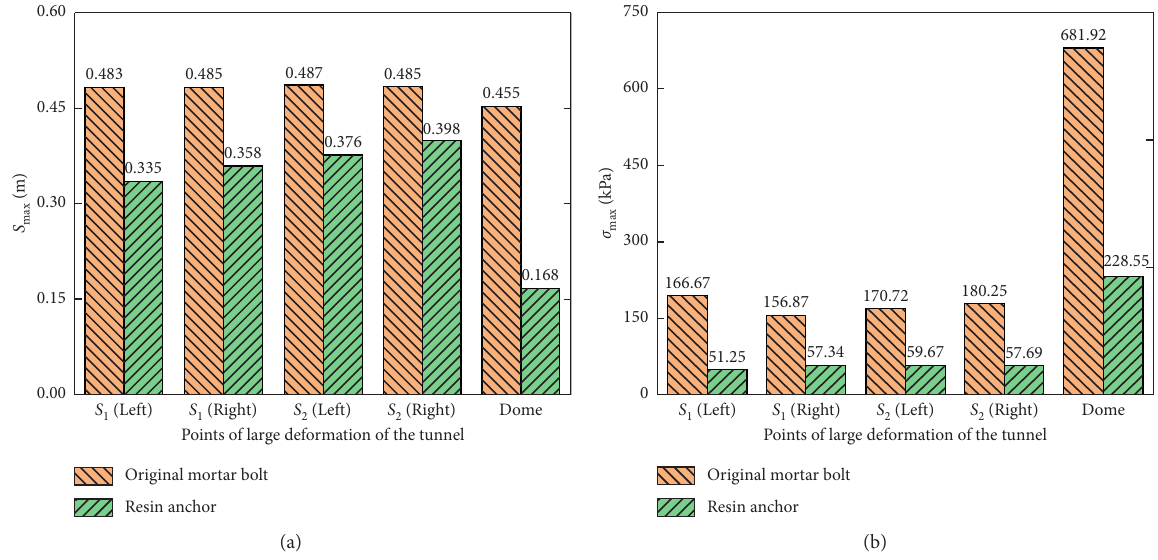
Figure 7: Original parameter mortar bolt and resin bolt support: (a) S